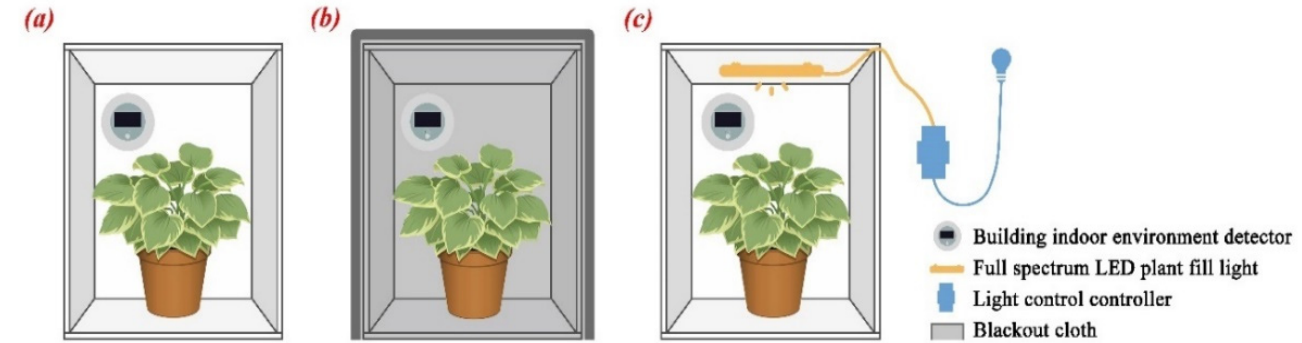
Figure 1. Experimental diagram of three different indoor lighting environments: ( a ) natural lighting environment ( b ) poor lighting environment and ( c ) all-day lighting environment.